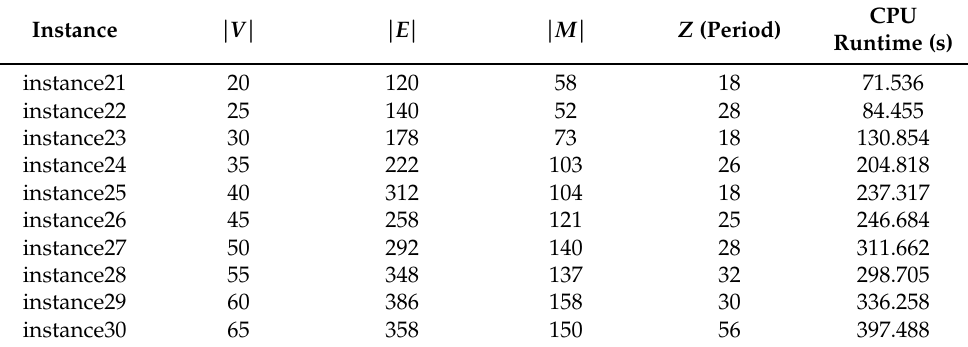
Table 5. Computational results for instances 21 to